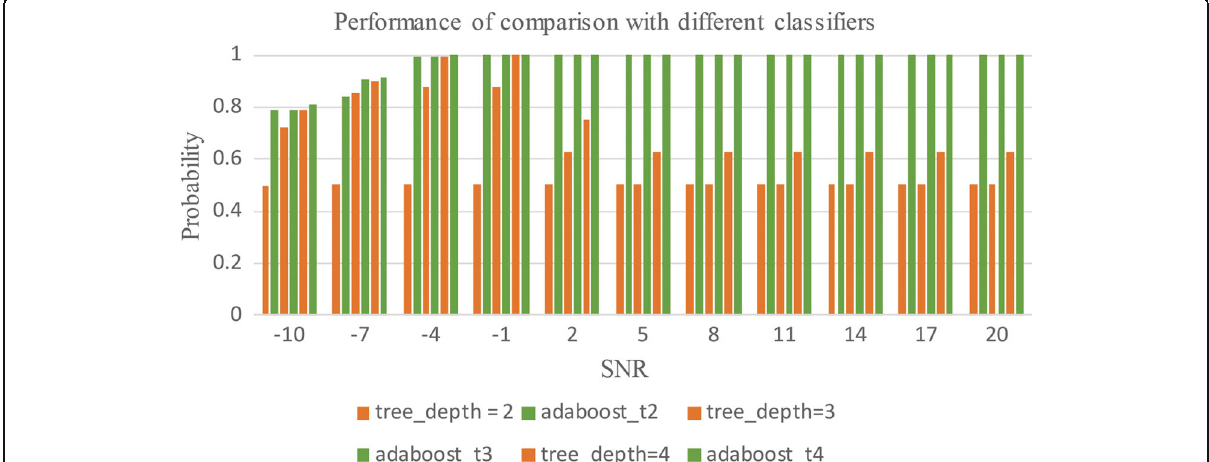
Fig. 3 Comparison of different tree depth between decision tree and AdaBoost algorithm with 800 rounds iteration. The right column always denotes decision tree with diverse depth, and the left one is AdaBoost. The correct order in legend is from left to right and up to down